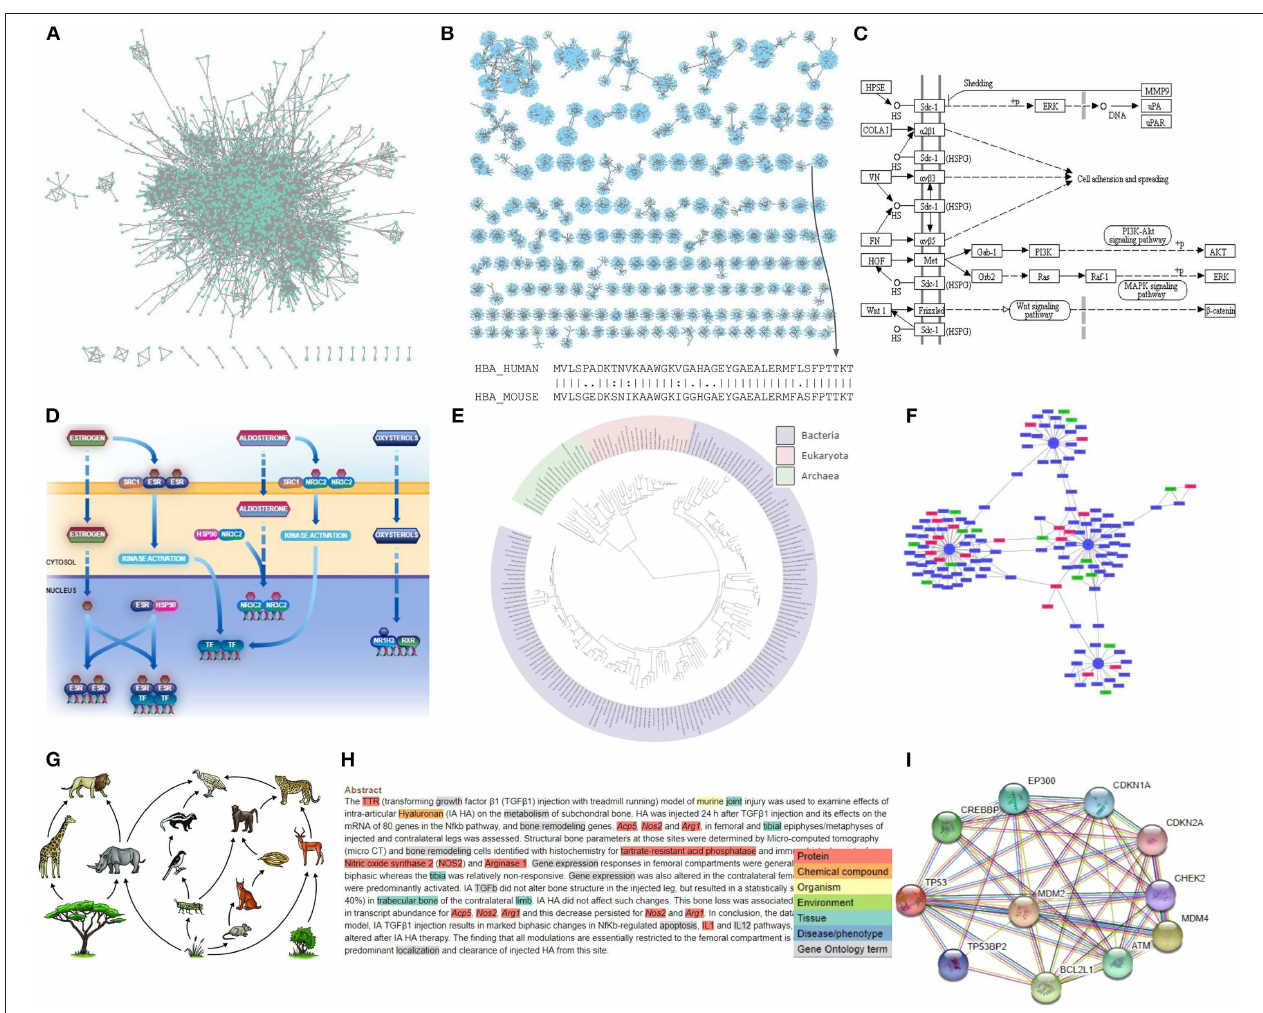
FIGURE 6 | Examples of biological networks. (A) A protein-protein interaction (PPI) network shown in Cytoscape. (B) A sequence similarity network visualized with Cytoscape. Each edge corresponds to an alignment score. (C) A KEGG metabolic pathway. (D) A Reactome signal transduction network. (E) The tree of life visualized by iTOL. (F) A gene expression network with up- (red) and down-regulated genes (green). (G) A Savanna food web (credit: Siyavula Education). (H) A tagged PubMed abstract showing abstract-based co-occurrences. (I) A STRING multi-edge PPI knowledge